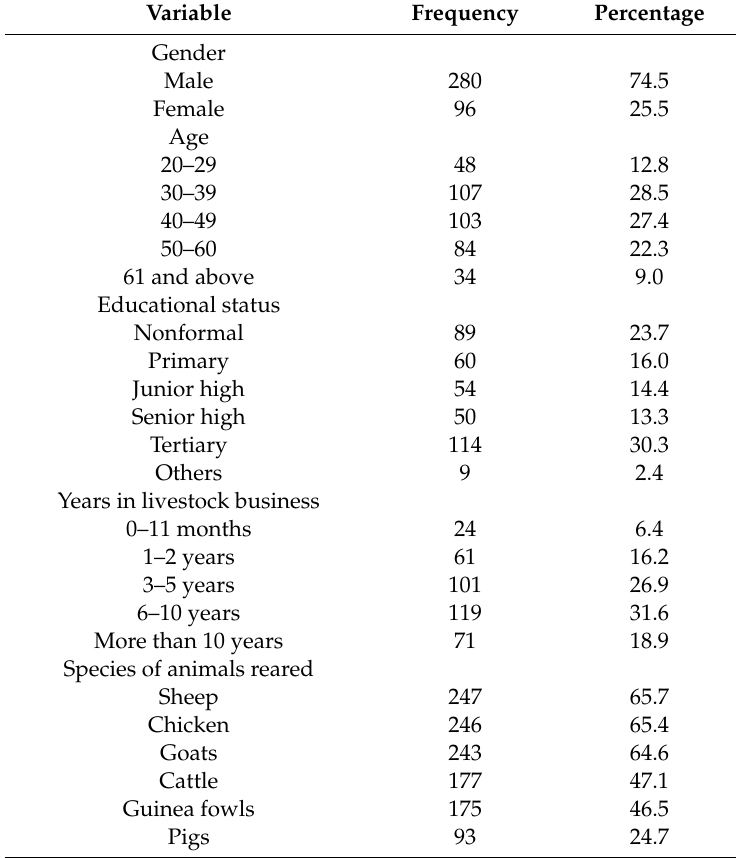
Table 1. The demographic characteristics of livestock farmers.